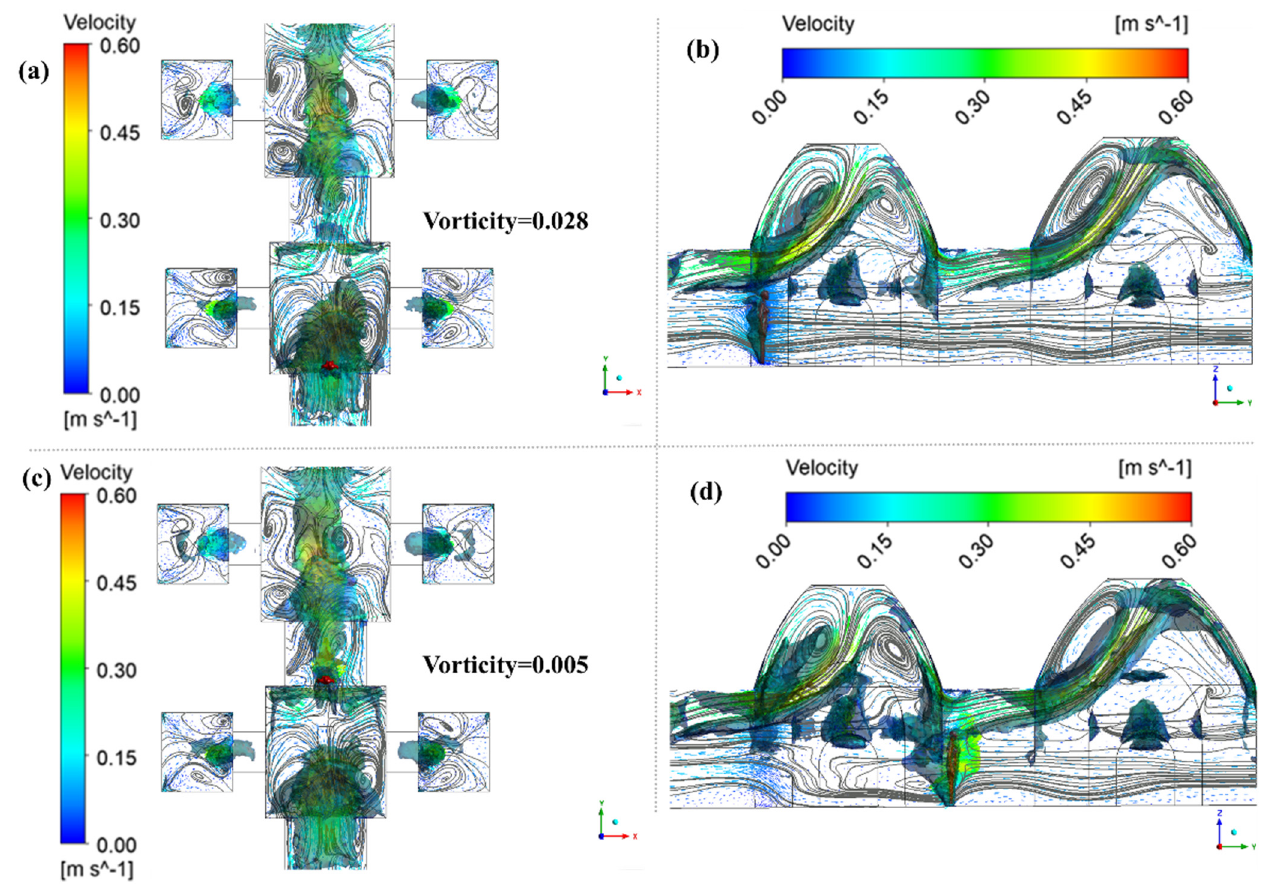
Figure 5 . Vorticity iso-surface diagram and velocity streamline diagram of different cross-sections: (a) the Z=1.2 m section of visitor standing up; (b) the X=0 m section of visitor standing up; (c) the Z=1.2 m section of visitor walking; (d) the X=0 m section of visitor walking.